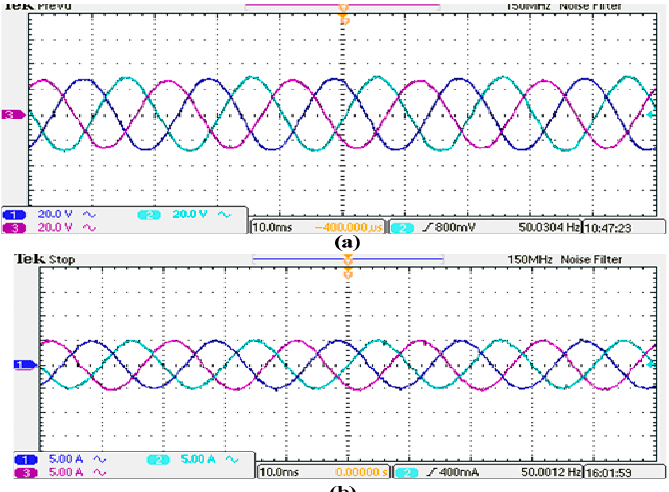
Figure 29. DFIG system in weak grid with low bandwidth improved PLL ( a ) Stator voltage, and ( b ) Stator current.